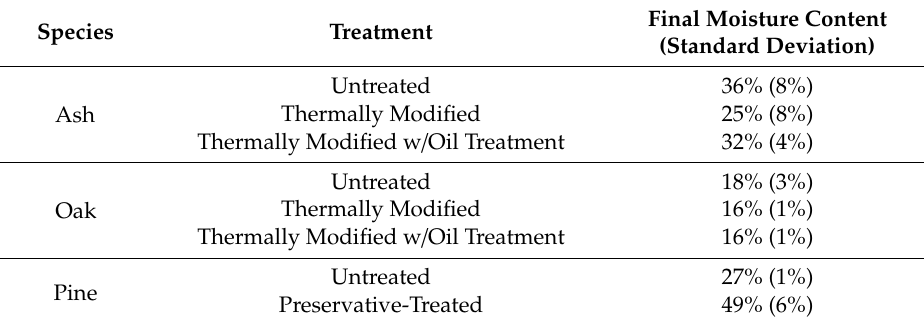
Table 2. Final wood moisture contents of the di ff erent wood species and treatments